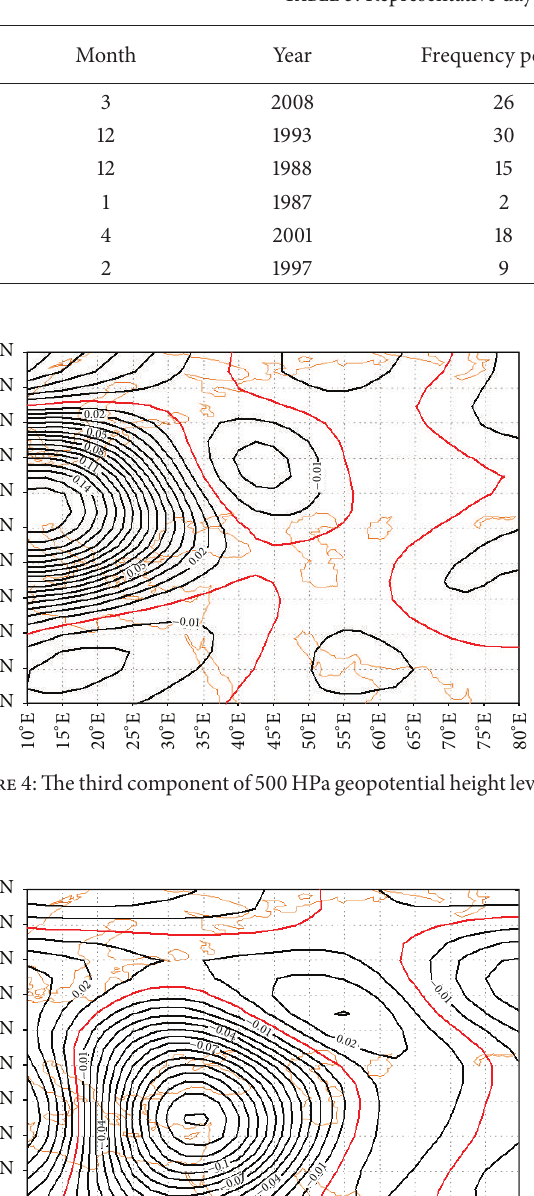
Table 3: Representative days in each cluster and their properties.